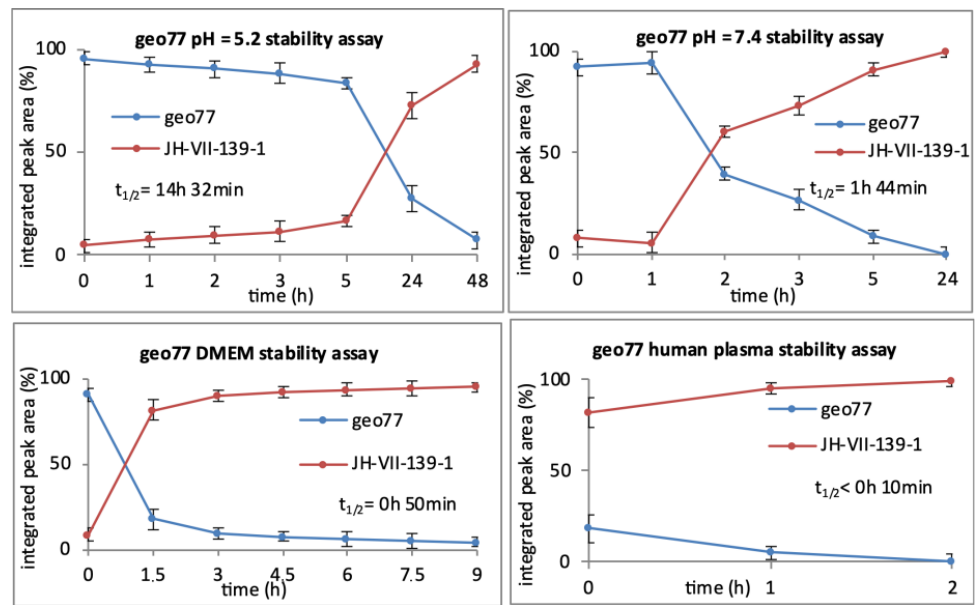
Figure 4. Chemostability of geo77 .